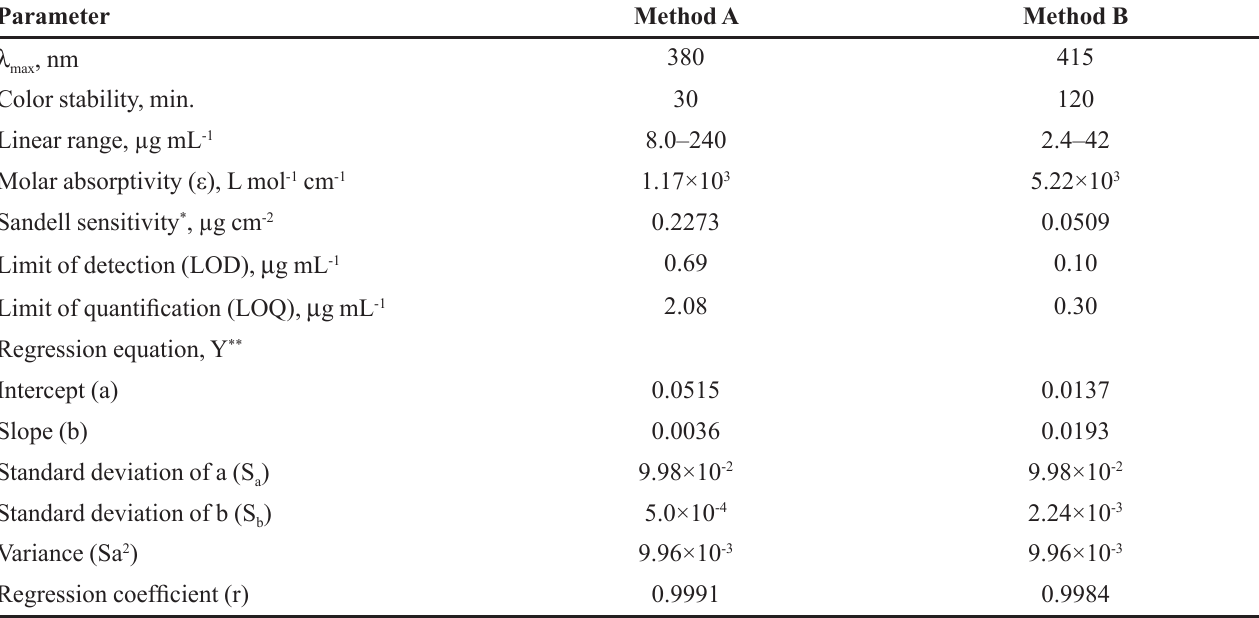
TABLE I - Sensitivity and regression parameters Parameter